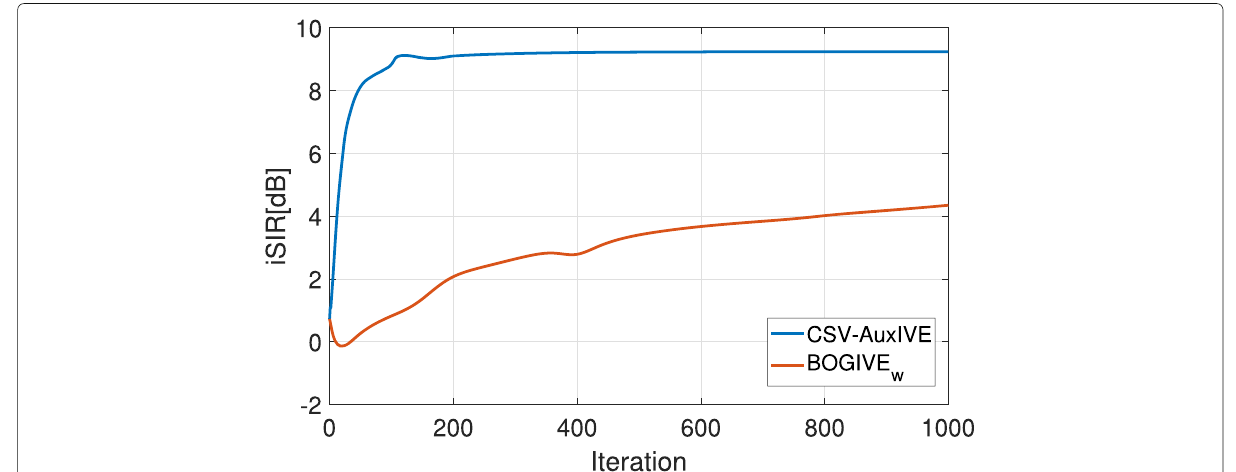
Fig. 3 The convergence of CSV-AuxIVE and BOGIVE w in term of SIR improvement averaged over 200 random mixtures in the experiment of Section 4.3; T 60 = 100 ms